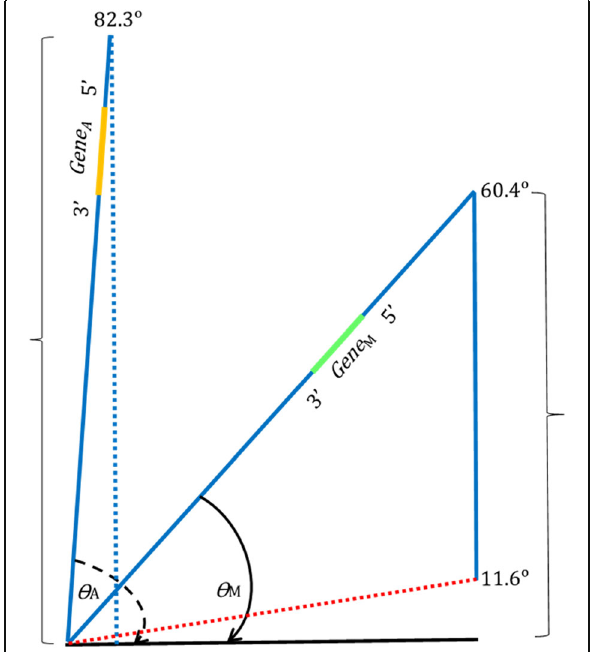
Fig. 4 Vectormetry for horizontal alignment of anisotropic and mesotropic genes by heterochromatin strand structural pressurotopy. Anisotropic gene loci are positioned between angles 82.3 and 60.5 0 in the z, y -vertical plane encounter the chromatin-associated protein viscosity effect at intergene segments. The effective momentum ( m eff ) in anisotropic gene alignment to the z , x -horizontal plane is m A = m ch tropy (- m pro-grav ch tropy ) as indicated by the left bracket. Mesotropic gene loci are positioned between angles 60.4 and 11.7 0 in the z, y -vertical plane encounter dual chromatin-associated protein viscosity effect at intergene segments and the nuclear membrane nucleoplasm chromatin- associated protein viscosity effect at intergene segments. The effective momentum ( m eff ) in mesotropic gene alignment to the z, x -horizontal plane is m M = m ch tropy + m ch nmn tropy (- m pro-grav ch tropy ) as indicated by the right bracket. The effective momentum ( m eff ) in gene transcription will be inversely proportional to the effective cell pressure ( P eff ) required for horizontal alignment of gene intergene loop segment tropy, P eff (0.064 ≥ x < 0.245) · m A = P eff (0.245 ≥ x ≤ 0.648) · m M . The initial momentum vector for anisotropic gene alignment, m ch tropy , will be greater as the origination point of anisotropic genes is 7.7 degrees ( 0 ) from the z , y -vertical, which require lesser applied pressure for horizontal alignment; whereas, the initial momentum vector for mesotropic gene alignment, m ch tropy + m ch nmn tropy ( m M ), will be lesser as the origination point of mesotropic genes is between 29.6 0 and 78.3 degrees ( 0 ) to the z , y -vertical plane, which require lesser applied pressure for horizontal alignment. Therefore, the effective momentum ( m eff ; m A , m M ) for gene transcription is inversely proportional to the effective cell pressure ( P eff ) required for horizontal alignment of gene intergene loop segment tropy. Legend. m ch tropy , left bracket; m ch tropy + m ch nmn tropy , right bracket; m pro-grav ch tropy , pro-gravitational momentum vector (not shown); P effective intracellular pressure ( P eff ) = P effective intranuclear